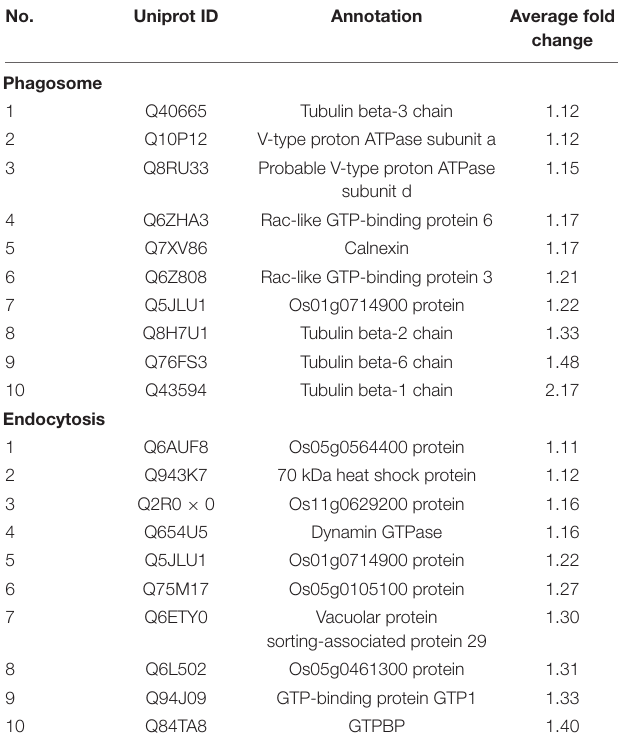
TABLE 1 | The list of up-regulated DEPs involved in phagosome and endocytosis according to KEGG enrichment analysis. No. Uniprot ID Annotation Average fold